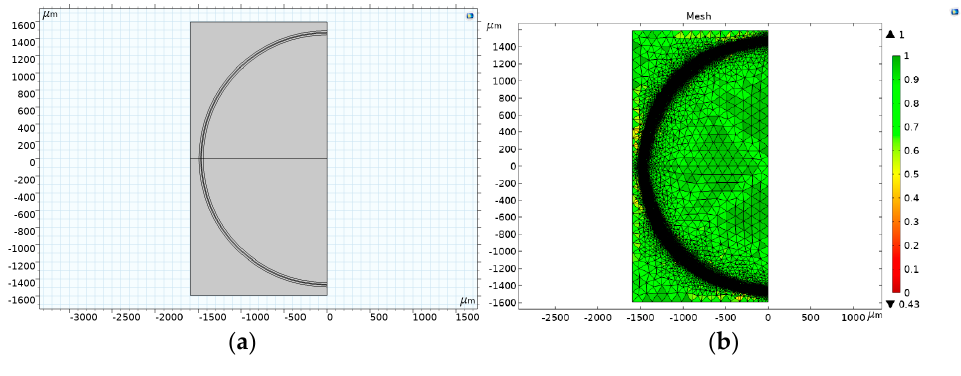
Figure 5. ( a ) Optical fiber model and ( b ) mesh analysis.